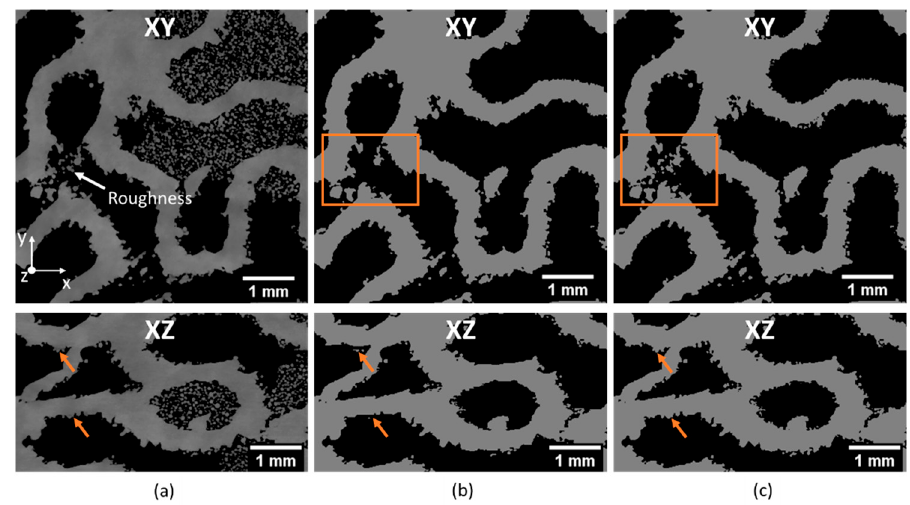
Figure 4. ( a ) A 2D reconstructed XY and XZ slices; ( b ) the result of the 2D DL segmentation of the scaffold only on XY planes; ( c ) the result of the combined segmentation on XY, XZ, and YZ planes. Orange boxes and arrows indicate the critical regions with surface roughness being wrongly segmented in ( b ).